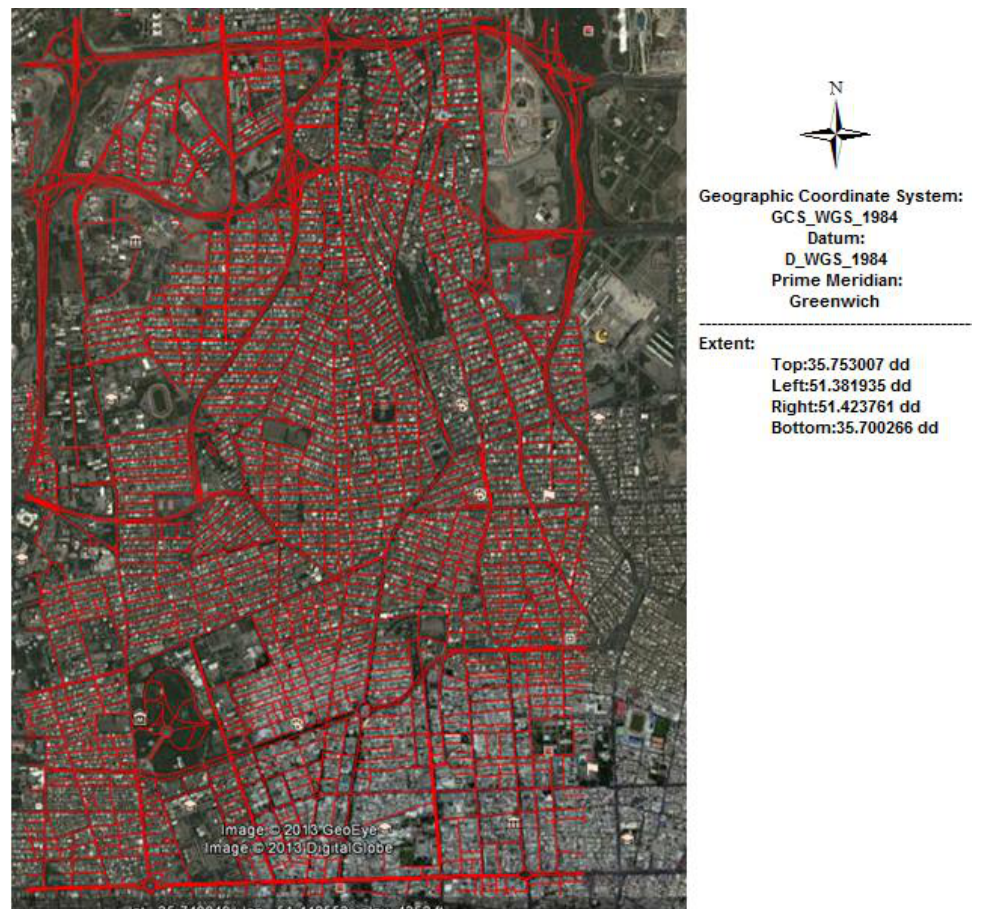
Figure 2. OpenStreetMap data of the study area overlaid on Google